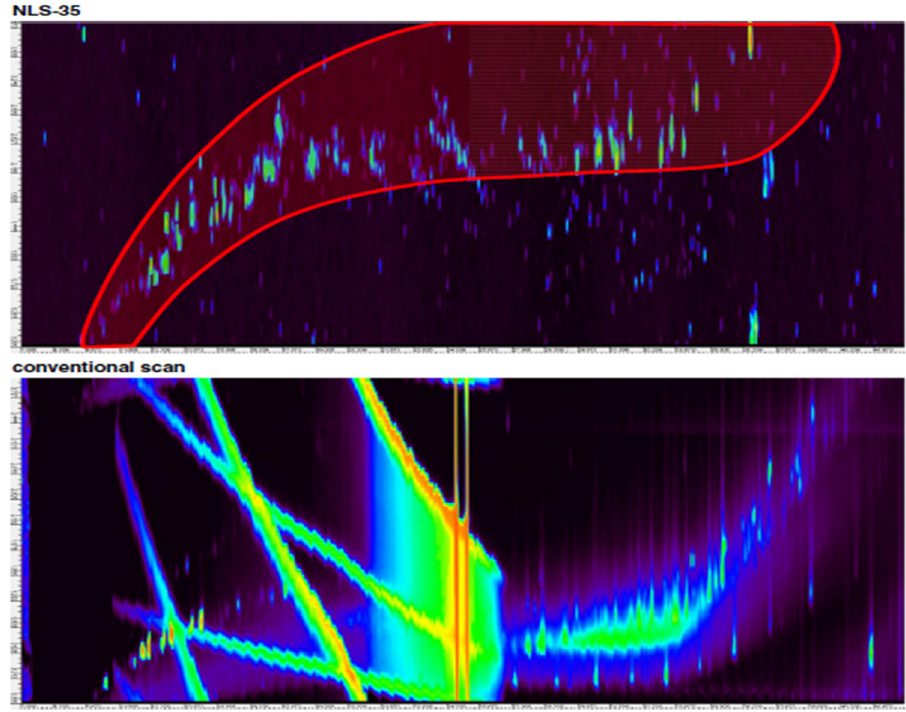
Figure 1: Two - dimensional total ion chromatograms ( TICs ) of a sediment sample ( NIES CRM20 ) , as measured by 35Cl neutral loss scanning ( NLS - 35, upper ) , which was expected to detect organochlorines selectively. The lower section shows scan obtained by a more conventional approach using GC × GC - MS/MS. The red translucent shape in the upper chromatogram shows the area where organohalogens were expected to appear [ 37 ]